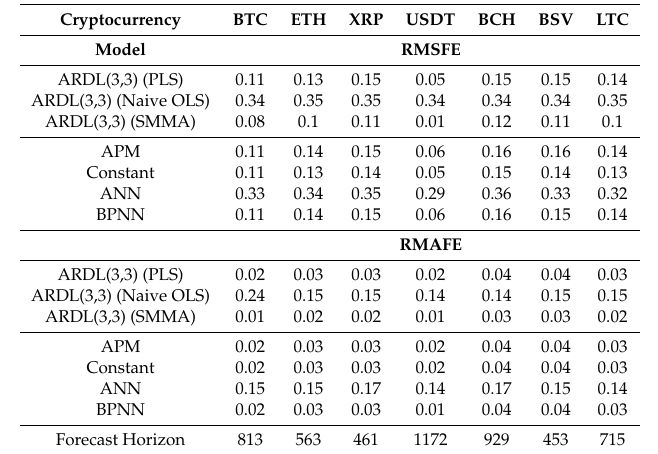
Table 8. Cryptocurrency returns one-step ahead forecast evaluation. RMSFE, root mean squared forecast error; RMAFE, root mean absolute forecast